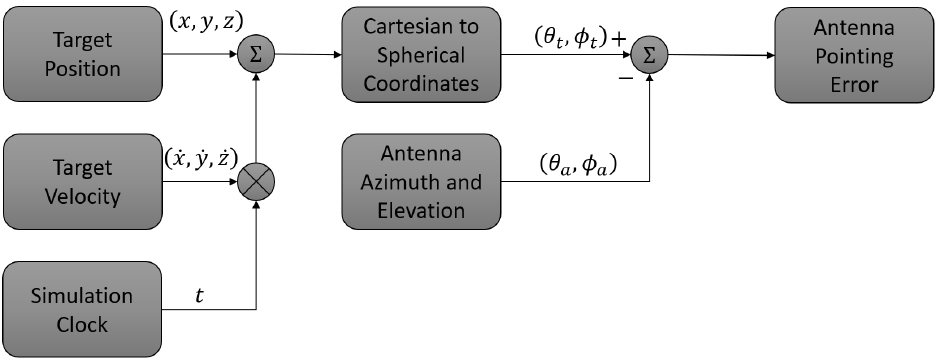
Figure 8. The Simulink model for the target movement using constant velocity targets. The target kinematic information is then converted to spherical coordinates and compared to the pointing location of the tracking antenna to provide range, azimuth, and elevation information for modelling the received signal power and